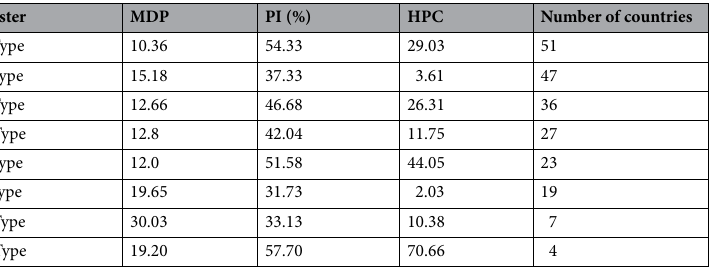
Table 1. Description of cluster centroids. MDP = minutes of average daily playtime per user; PI = playtime inequality, i.e., the percentage of a region’s total playtime which came from the top 1% of players; HPC = hours of yearly playtime per capita. Cluster labels after representative animals from the specific regions. Cluster labels do not imply a ranking or commentary but is purely descriptive with animal size a rough indicator of total play per capita for the cluster.